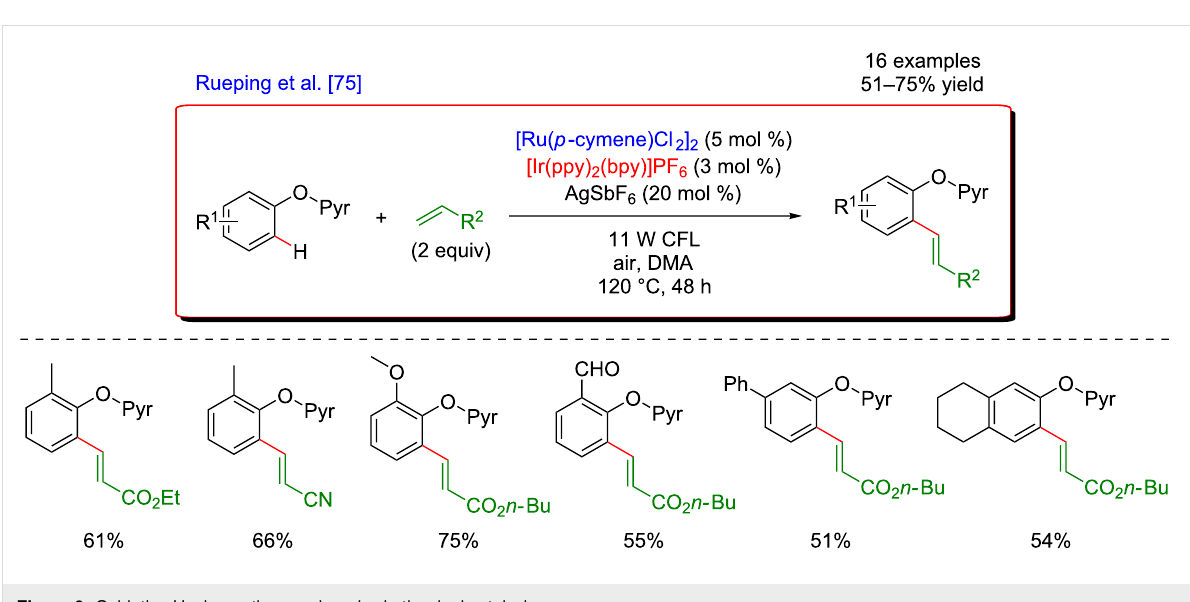
As in the previously described examples, molecular oxygen plays a key role in the mechanism of the C–H functionalization (Figure 10). Indeed, both the photoexcited Ir-based catalyst and